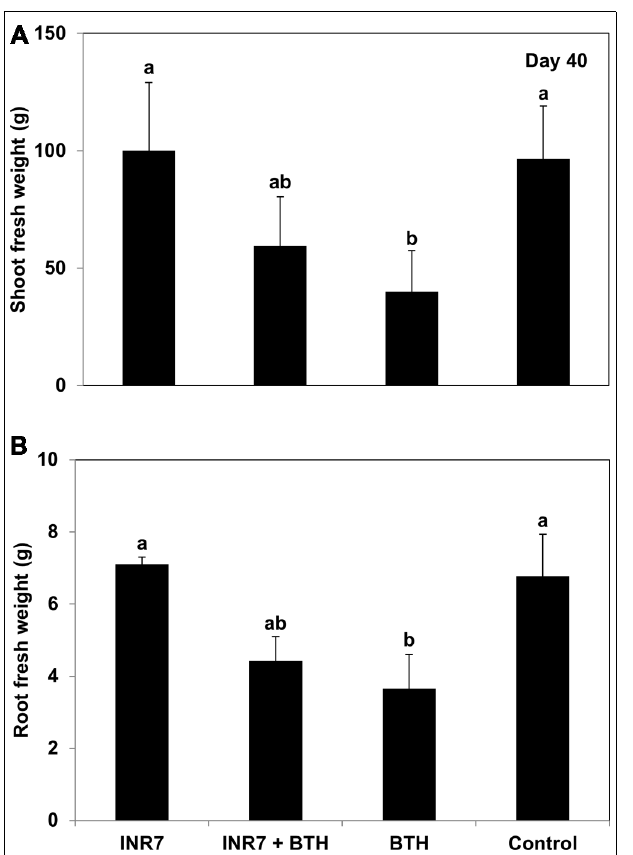
FIGURE 4 | Growth responses of B. pumilus INR7, BTH, and INR7 + BTH in pepper under field condition. (A) The shoot fresh weight and (B) root fresh weight were measrued 40 days after bacteria and chemical treatments. Bars represent the mean ± SE (sample size, N = 40 replications per treatment). Different letters indicate significant differences between treatments ( P = 0.05 according to least significant difference).